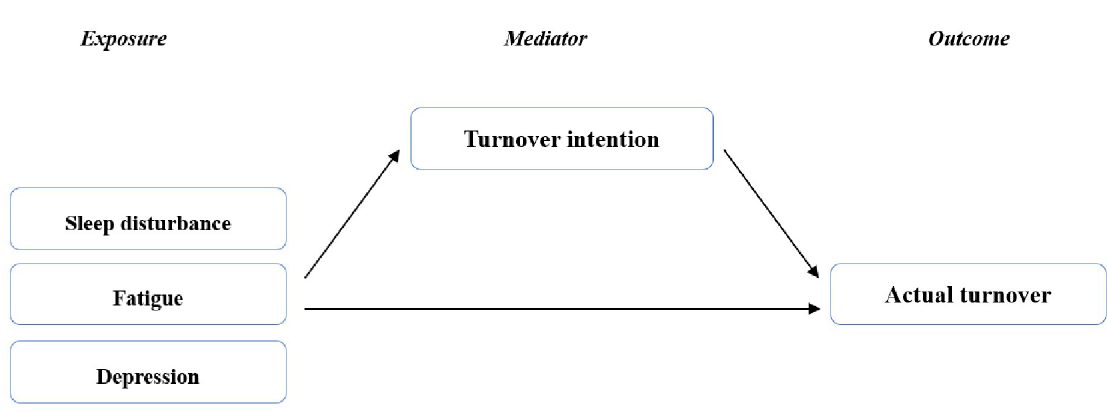
Fig 1. Directed acyclic graph for the mediation